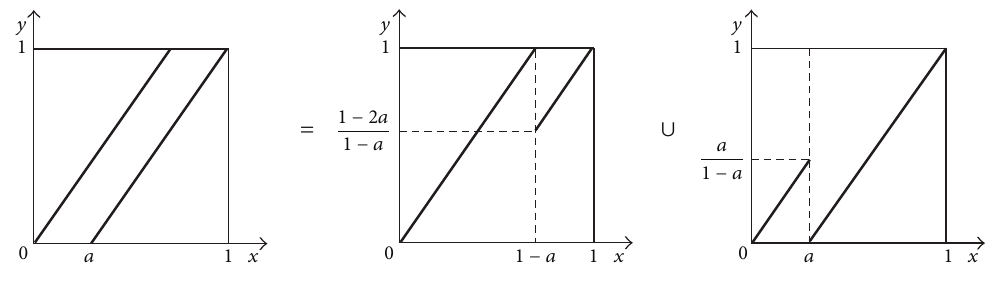
Figure 1: The design of 2 -transformation 𝑆